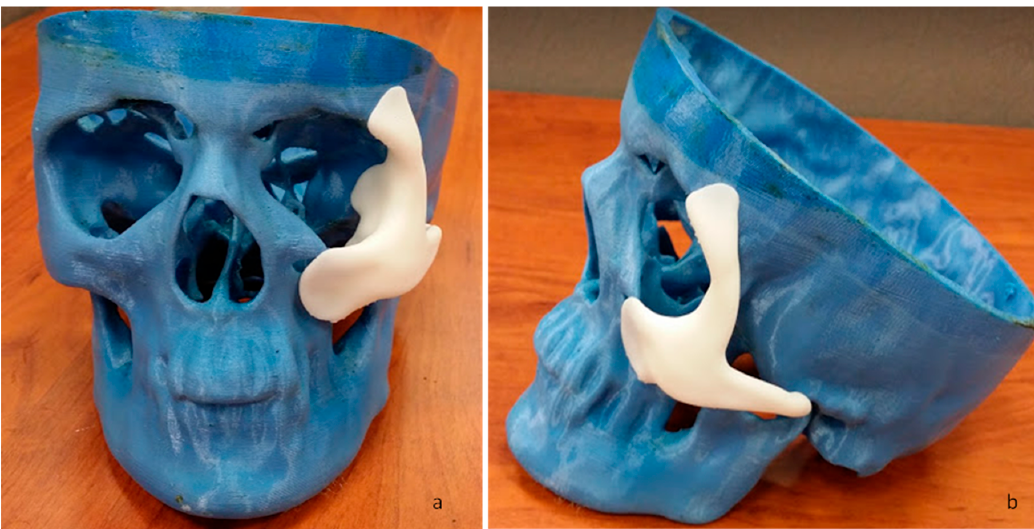
Figure 5. Silicone based zygomatic implant produced manually without CAD technique ( left ) and FDM fabricated zygomatic implant by CAD mirroring technique ( right ).